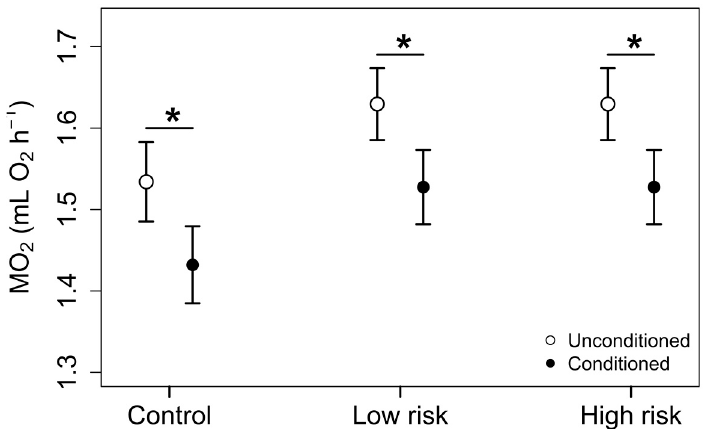
Figure 4. Oxygen consumption (mL O 2 h –1 ) of conditioned and unconditioned hellbenders exposed to varying levels of kairomone concentrations, after accounting for mass and proportion of time active during the exposure trials. Estimates are presented as marginal means with standard errors. Conditioned individuals had consistently lower oxygen consumption at each of the exposure levels compared to unconditioned individuals, but the rate of oxygen consumption did not differ across exposure levels. Asterisks denote significant differences between conditioning treatments ( p < 0.05).